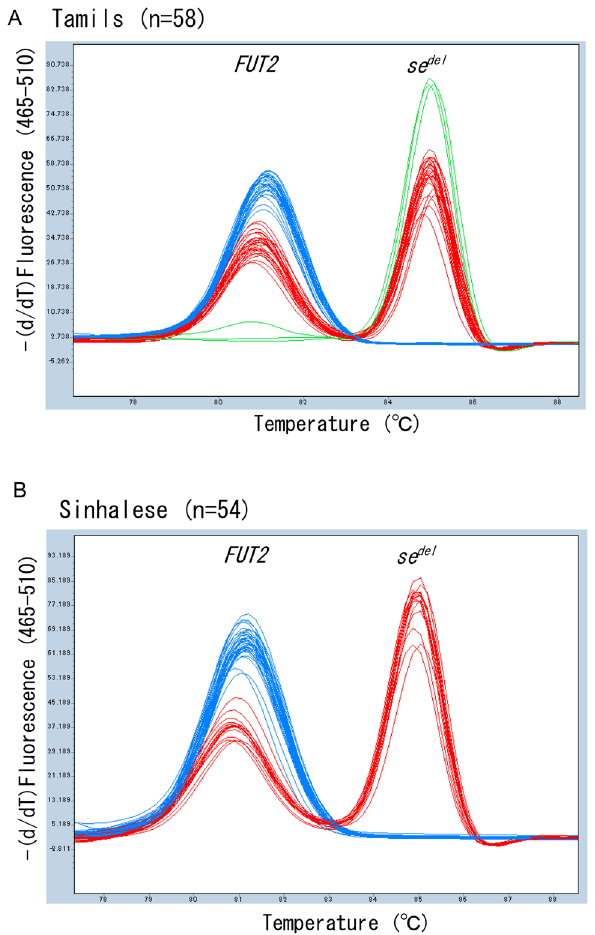
Figure 2. Melting peak profiles of duplex PCR for detection of se del zygosity. Melting peak profiles obtained for 58 randomly selected Tamils ( A ) and 54 randomly selected Sinhalese ( B ). The individuals with genotypes of +/+ (wild type, blue), +/− (heterozygote of se del , red), and −/− (homozygote of se del , green) were completely separated by melt curve